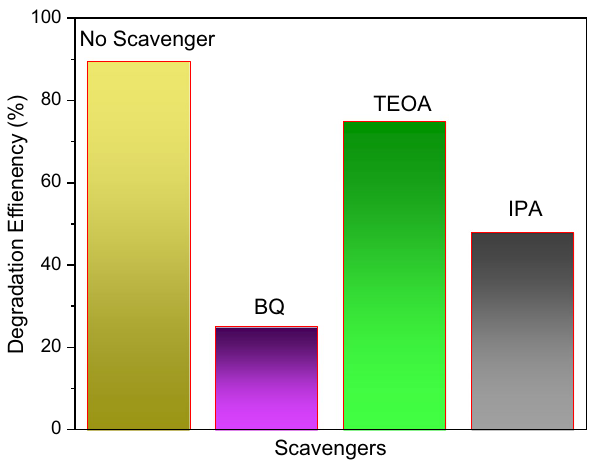
Fig. 13 Effects of different scavengers on the degradation of MO dye in the presence of 4% Zr-doped SnO 2 NPs